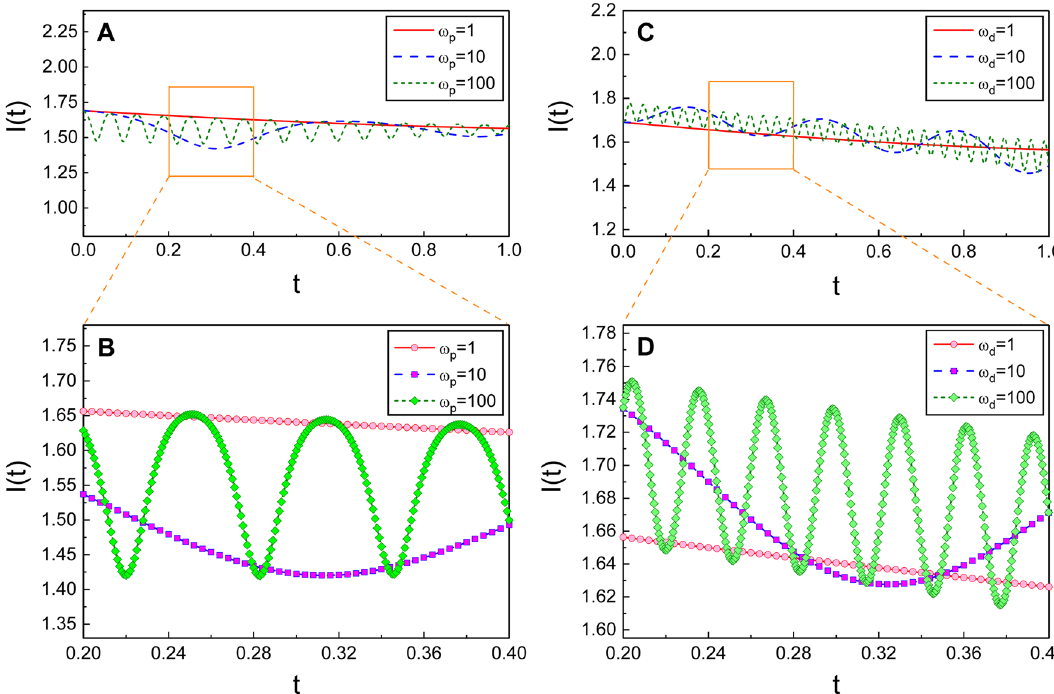
Figure 2. The effects of the increase of the frequencies ω p and ω d on temporal evolution of the Rayleigh- Lorentz invariant, where a sinusoidal noise ξ( t ) = ξ 0 cos (ω d t + θ) has been taken. Here, ξ 0 is the amplitude of the external force and ω d is the driving frequency. ( A ) is for several different values of ω p , whereas ( C ) for ω d . We have used ω d = 1 for ( A ) and ω p = 1 for ( C ). Other quantities that we have used are ω r = 0.5 , ǫ = 0.1 , β = 1 , Q = 5 , ξ 0 = 0.2 , E ( 0 ) = 1 , C = 1 , and θ = 0 . ( B ) and ( D ) are enlarged plots between t = 0.2 and t = 0.4 for ( A ) and ( C ),